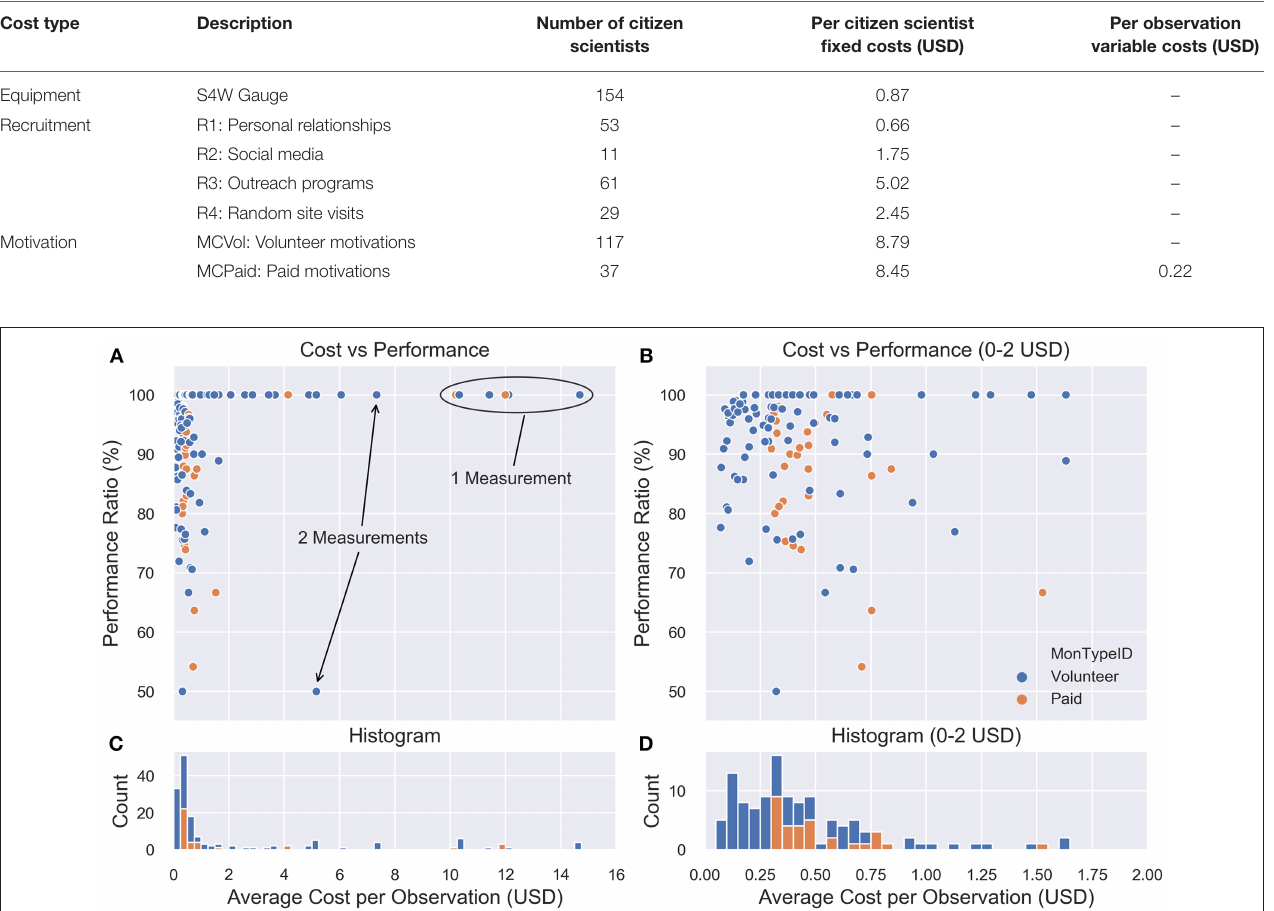
FIGURE 11 | Scatter plots of performance ratio (PR) as a function of average cost per observation for costs from (A) 0–16 USD and (B) 0–2 USD ranges, respectively. Each point represents the performance ratio and average cost per observation for a single citizen scientist. Histograms below show the total number of